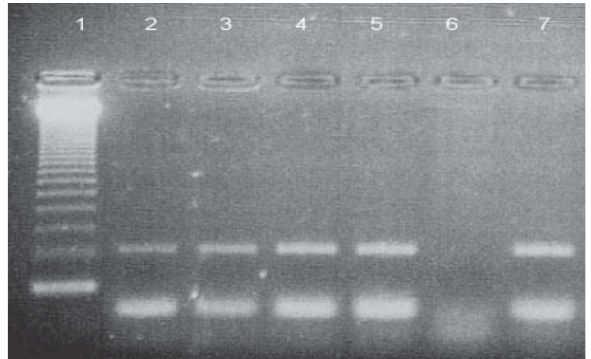
Fig. 1. Amplification of the 246 bp region in the stem tis- sue of peach seedlings inoculated with 1 (cid:1) 10 3 cfu ml -1 (2); 1 (cid:1) 10 5 cfu ml -1 (3); 1 (cid:1) 10 7 cfu ml -1 (4). Bacterial suspen- sions and root tissues of plants inoculated with 1 (cid:1) 10 7 cfu ml -1 (5). Negative control (6). Positive control (7). Lane 1, 123 bp ladder.